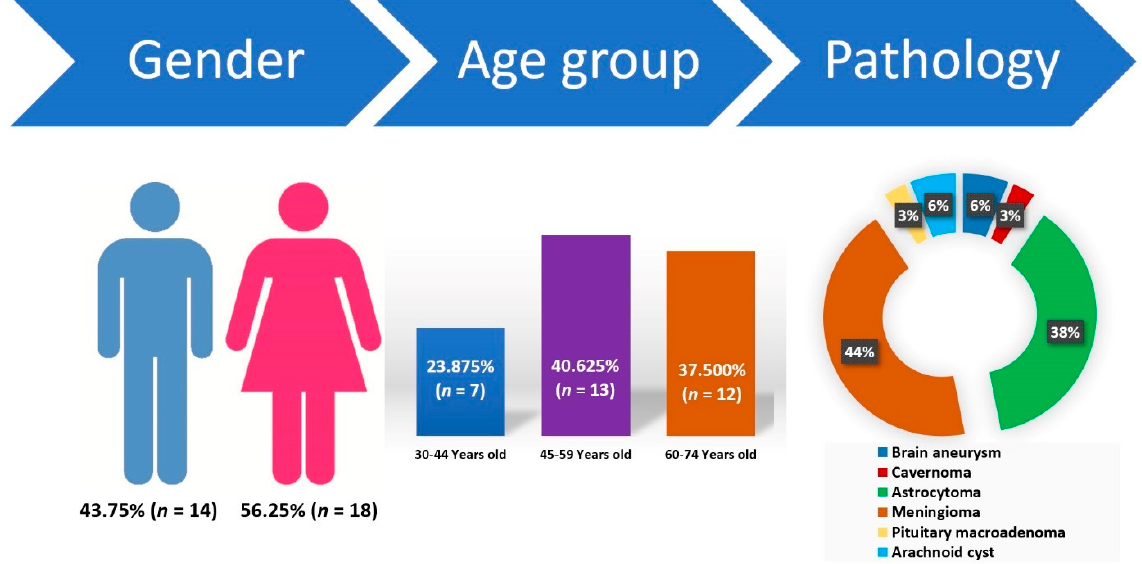
Figure 1. Demographic characteristics and indications for neurosurgery for the enrolled patients: female to male ratio, age distribution of the participants, and distribution of the pathologies. All surgical procedures were performed by the same senior neurosurgeon (C.M.) using the pterional craniotomy approach, as described in Section